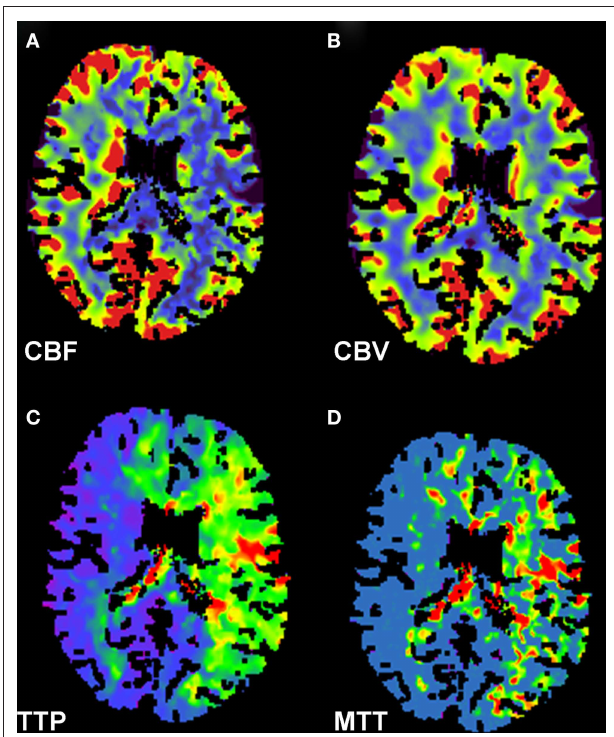
FIgure 3 | CT perfusion scan of the head demonstrates findings consistent with large ischemic penumbra. Decreased cerebral blood flow (A) , preserved cerebral blood volume (B) , and prolonged time to peak (C) and mean transit time (d) in the left middle cerebral and bilateral anterior cerebral artery distributions are